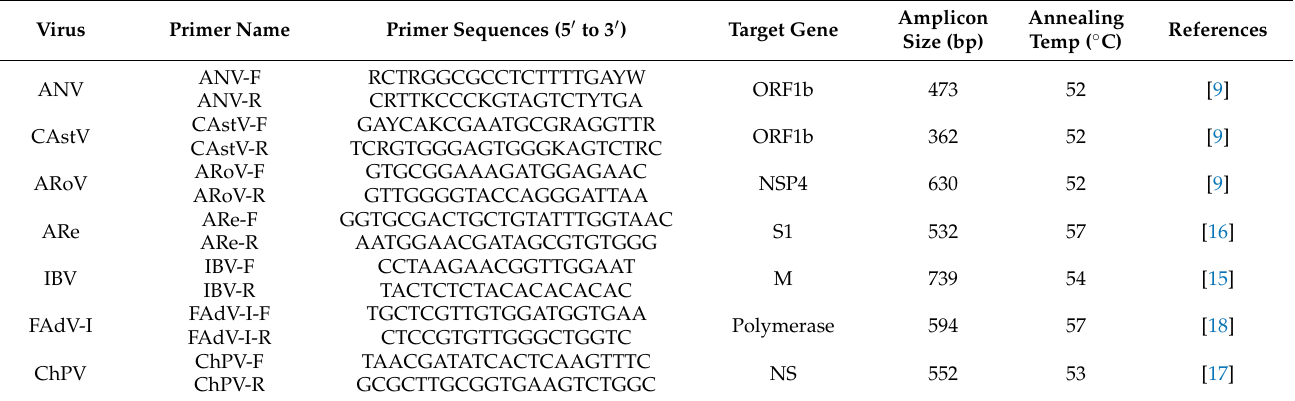
Table 1. Primers sequences, gene target, amplicon size, and the corresponding references that were used to screen for the enteric viruses by RT-PCR and PCR